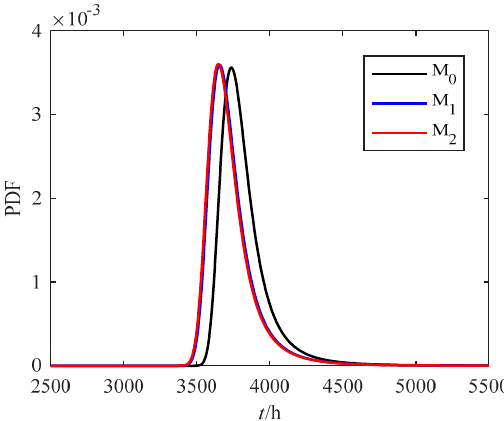
Figure 3. Comparison of PDF of lifetime at 75 °C for accelerometers.